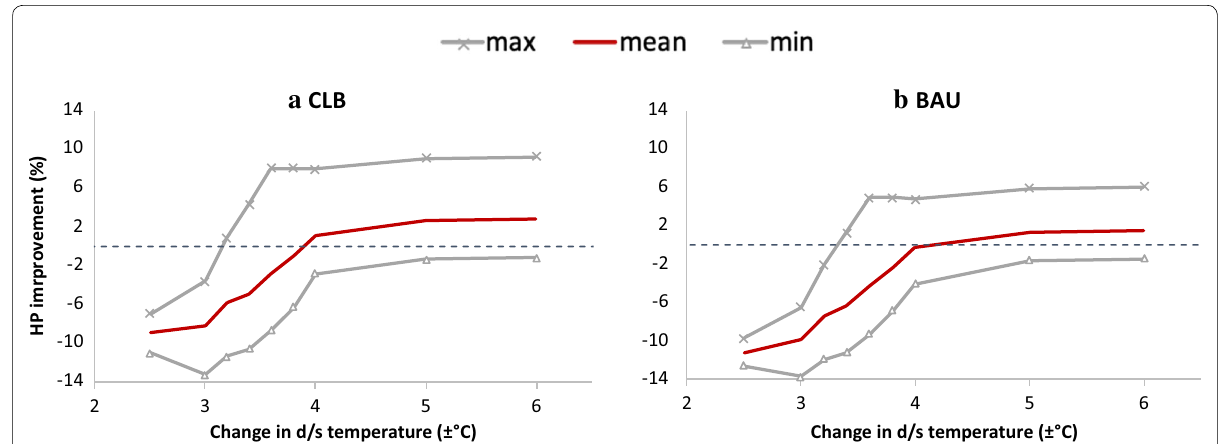
Fig. 12 Tradeoff curve for improvement in hydropower generation (HP) over benchmarks of a CLB and b BAU scenario, with varying temperature constraints. The curve is derived from 5 years of optimization runs performed for Detroit dam involving a series of dry and wet flow regimes